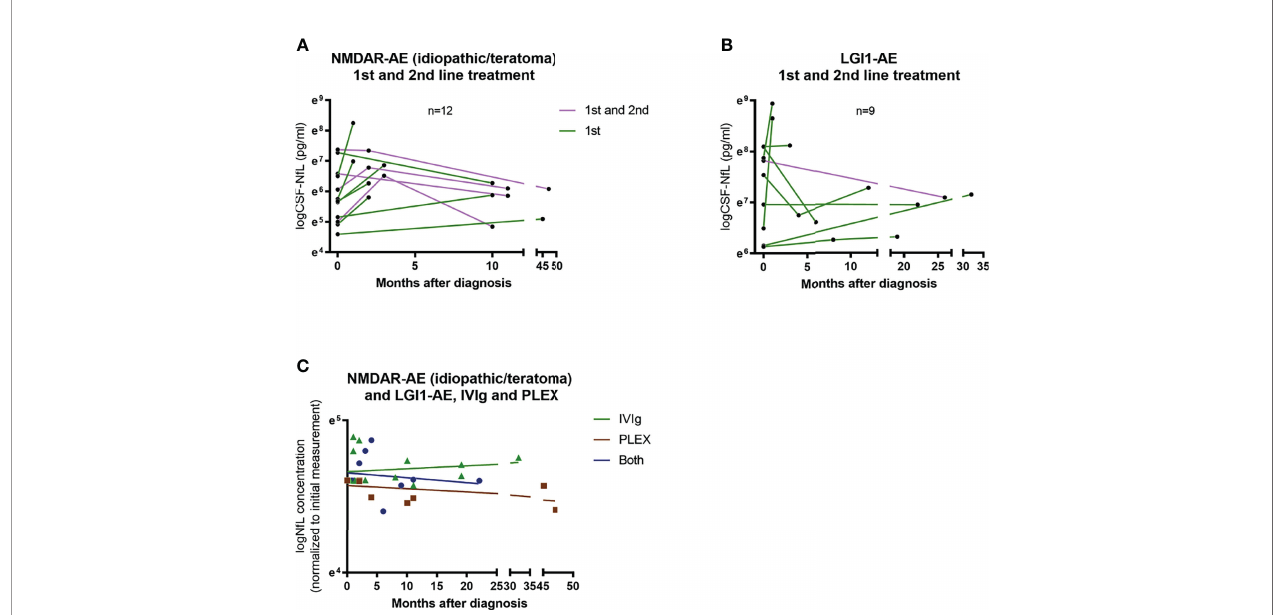
FIGURE 6 | CSF-NfL levels and treatment regimens. Overview of patients (idiopathic/teratoma associated NMDAR-AE n=12 and LGI1-AE n=9) with available follow- up CSF-NfL measurements and if they received fi rst or second line therapy (A, B) . A comparison between follow-up CSF-NfL values and different fi rst line treatment strategies showed a tendency towards lower follow-up CSF-NfL values in patients treated with PLEX or a combination of PLEX/IVIg (C) . Patients only receiving IVIg are shown as green ▲ . Patients only receiving PLEX are shown as brown ▪ . And patients receiving both as blue ●